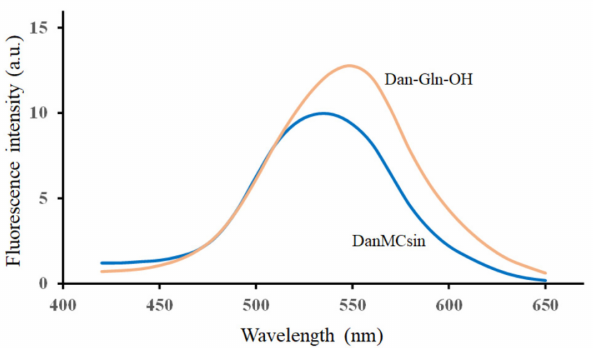
Figure 6. Fluorescence spectra of DanMCsin (blue) and Dan-Gln-OH (orange) in 40 mM ammonium acetate (pH 4.5) with an excitation wavelength at 336